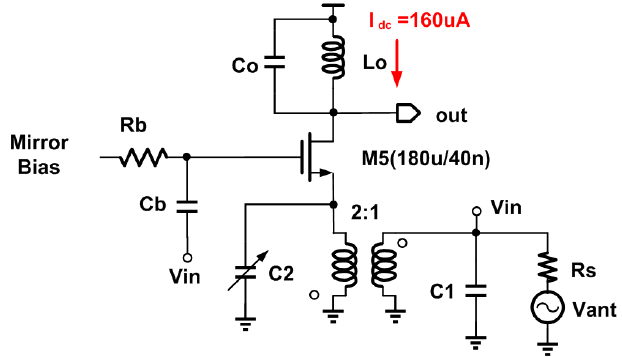
Figure 3. Schematic of ultra-low voltage (ULV) low-noise amplifier (LNA).